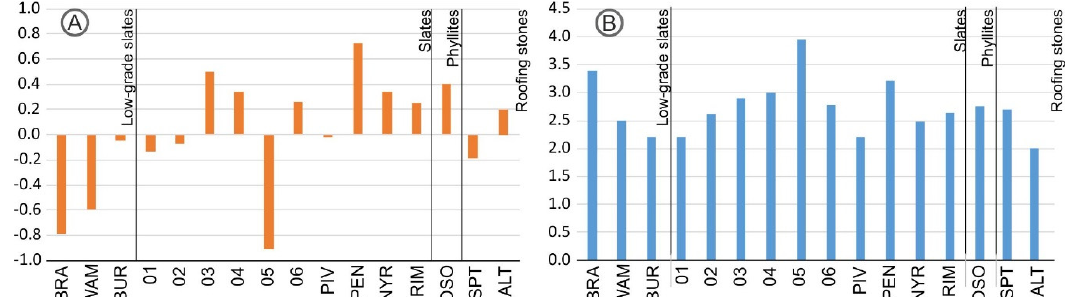
Figure 6. Skewness ( A ) and kurtosis ( B ) analysis of the height distribution for each sample. Skewness ( A ) represents the degree of symmetry of the surface heights across the mean plane: Positive values indicate a predominance of crests, and negative values indicate a predominance of troughs. Kurtosis ( B ) indicates the presence of significant high peaks and/or deep valleys (Sku > 3), or the absence thereof (Sku < 3) (i.e., smooth surfaces).